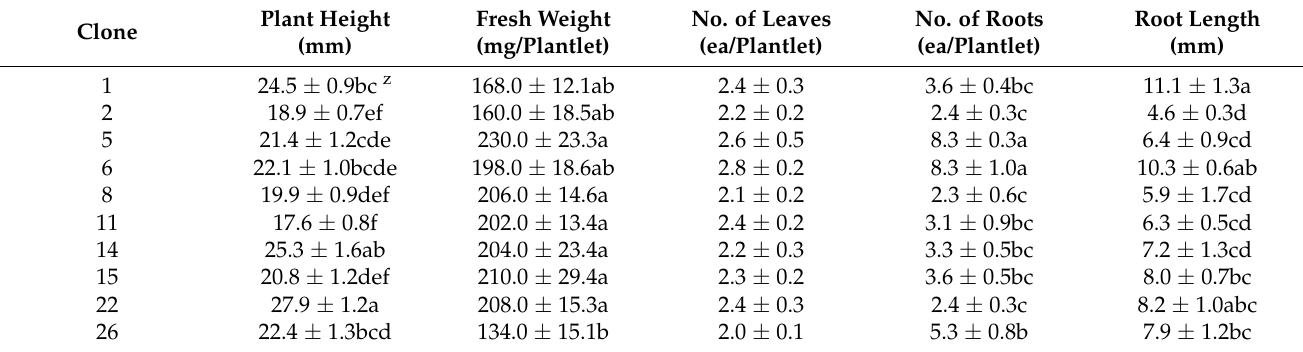
Table 2. Growth characteristics of ten in vitro-grown clones of Cnidium officinale .